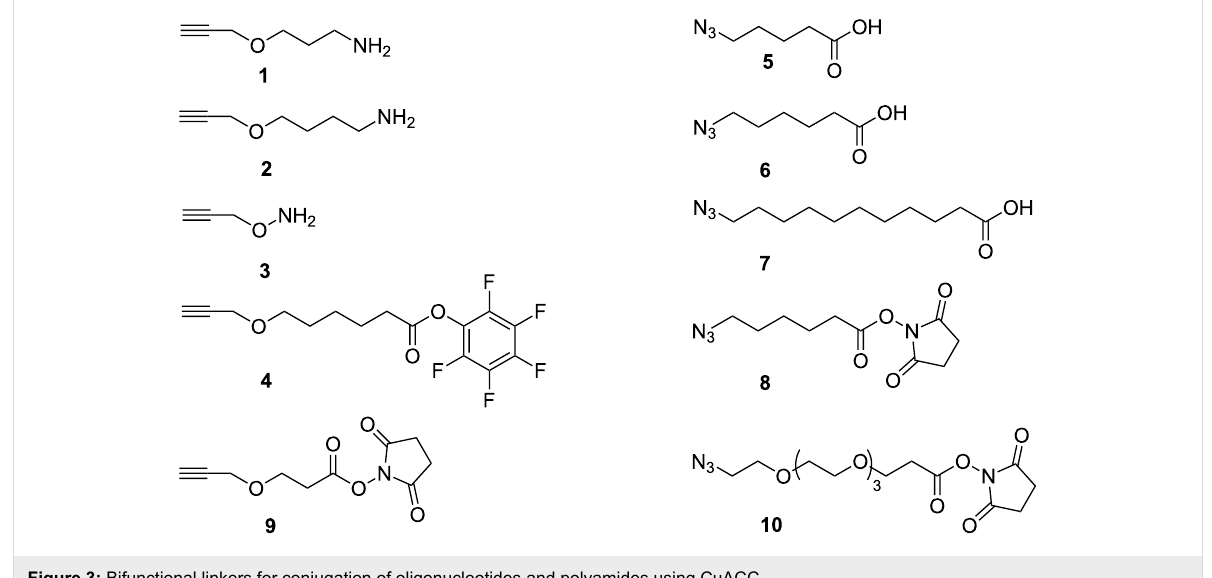
Figure 3: Bifunctional linkers for conjugation of oligonucleotides and polyamides using CuACC.